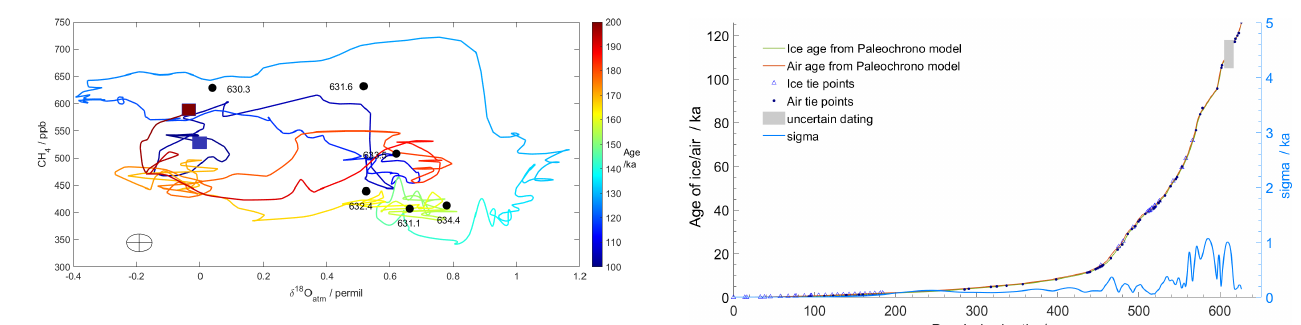
Figure 10. Cross plot of CH 4 (Köhler et al., 2017; Loulergue et al., 2008) and δ 18 O atm (Extier et al., 2018) reference data for the period 100–200ka. The colour bar indicates the age of the sample. Also shown are the Skytrain data from 630m downwards (black dots). The combined uncertainty (used to decide whether a match between the Skytrain and reference data is acceptable) is shown by the grey ellipse/cross. The start (200ka) and end (100ka) of the reference curve are marked by red and blue squares. An alternative visualisation of this figure is provided in Fig. S7.